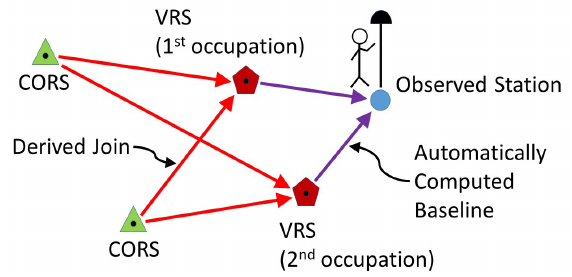
Fig. 6. NRTK automatic baseline network being connected to datum via a join between each VRS and the two nearest